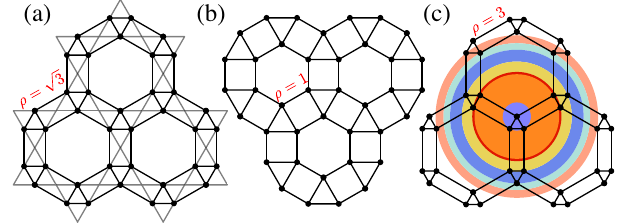
FIG. 9. The ruby lattice. (a) Atoms on the links of the kagome lattice form the vertices of a ruby lattice where the rectangle has ffiffiffi p 3 an aspect ratio ρ ¼ . (b) The ruby lattice with ρ ¼ 1 . (c) The ruby lattice with ρ ¼ 3 . The colored disks show seven distinct interaction distances; the phase diagram in Fig. 10 is obtained by including V ð r Þ ¼ Ω ð R b =r Þ 6 for 16 distinct distances, coupling each site to 44 other